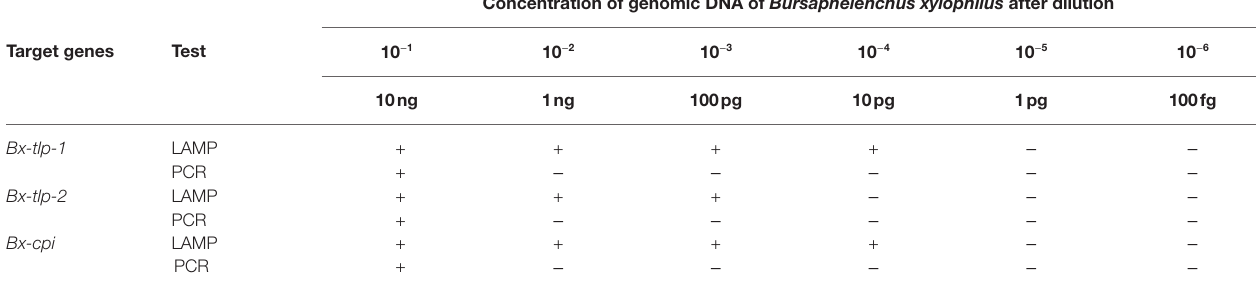
TABLE 3 | Comparison of the LAMP and PCR assay sensitivities.